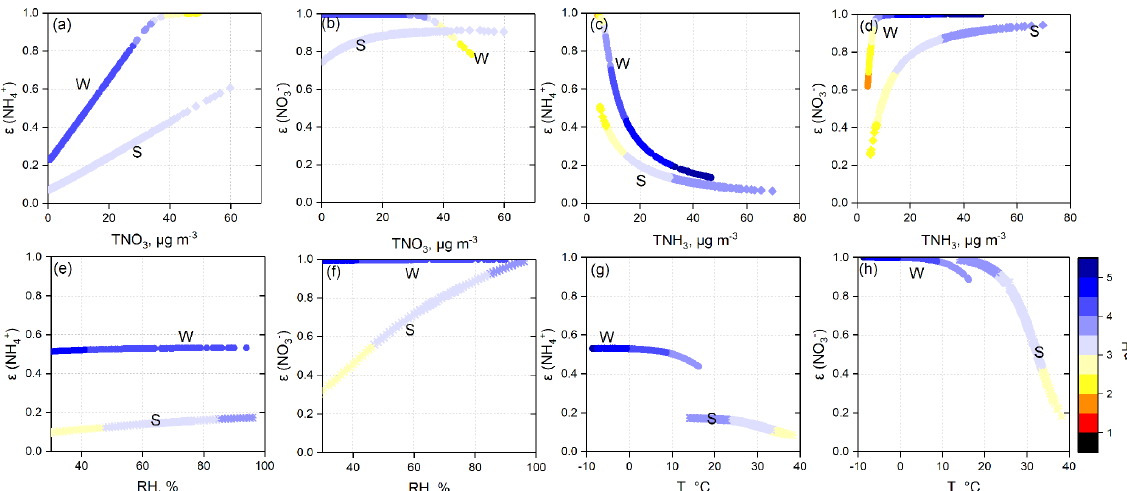
Figure 8. Sensitivity tests of ε (NH +